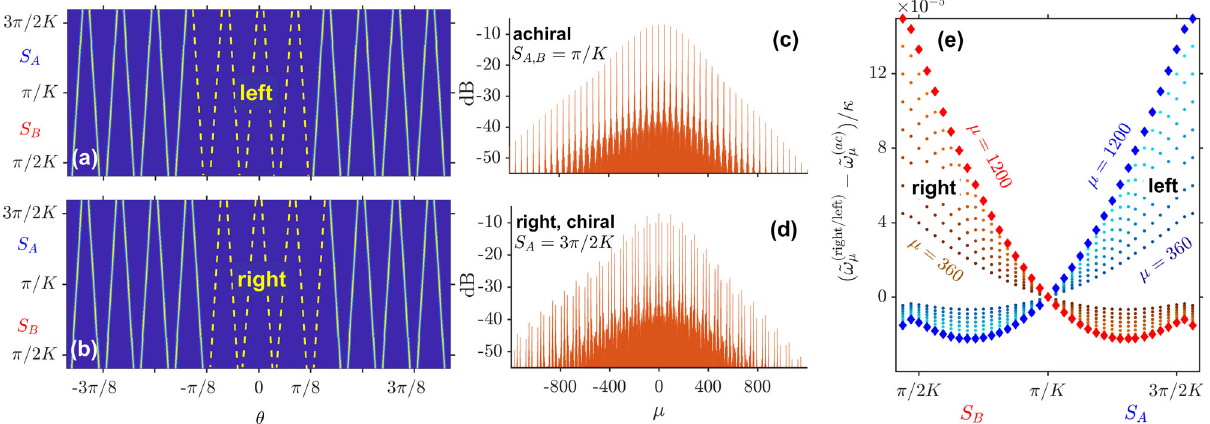
Fig. 5 Chirality of soliton metacrystals with defects. a , b show metacrystals with the differently arranged 7-soliton defects and K = 24. a , b geometries are called left and right, respectively. The missing soliton locations are marked with dashed lines. Note that the θ -interval shown is < 2 π . c , d show the examples of spectra of the achiral and chiral defects. e shows the normalised frequency spectra of the crystals with the right and left defects, i.e., ~ ω ð right Þ μ and ~ ω ð left Þ μ , minus the ~ ω ð ac Þ μ spectrum corresponding to the achiral geometry, S α = π / K . Red dots correspond to the right defect, ð ~ ω ð right Þ μ (cid:2) ~ ω ð ac Þ μ Þ = κ , and blue dots to the left one, ð ~ ω ð left Þ μ (cid:2) ~ ω ð ac Þ μ Þ = κ . The values of μ shown are restricted to μ ∈ [360, 1200], with the step being